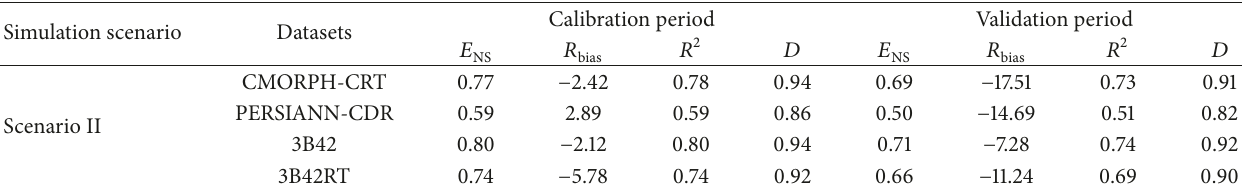
Table 5: Skill indices of HEC-HMS simulations for the calibration and validation periods under scenario II. Simulation scenario